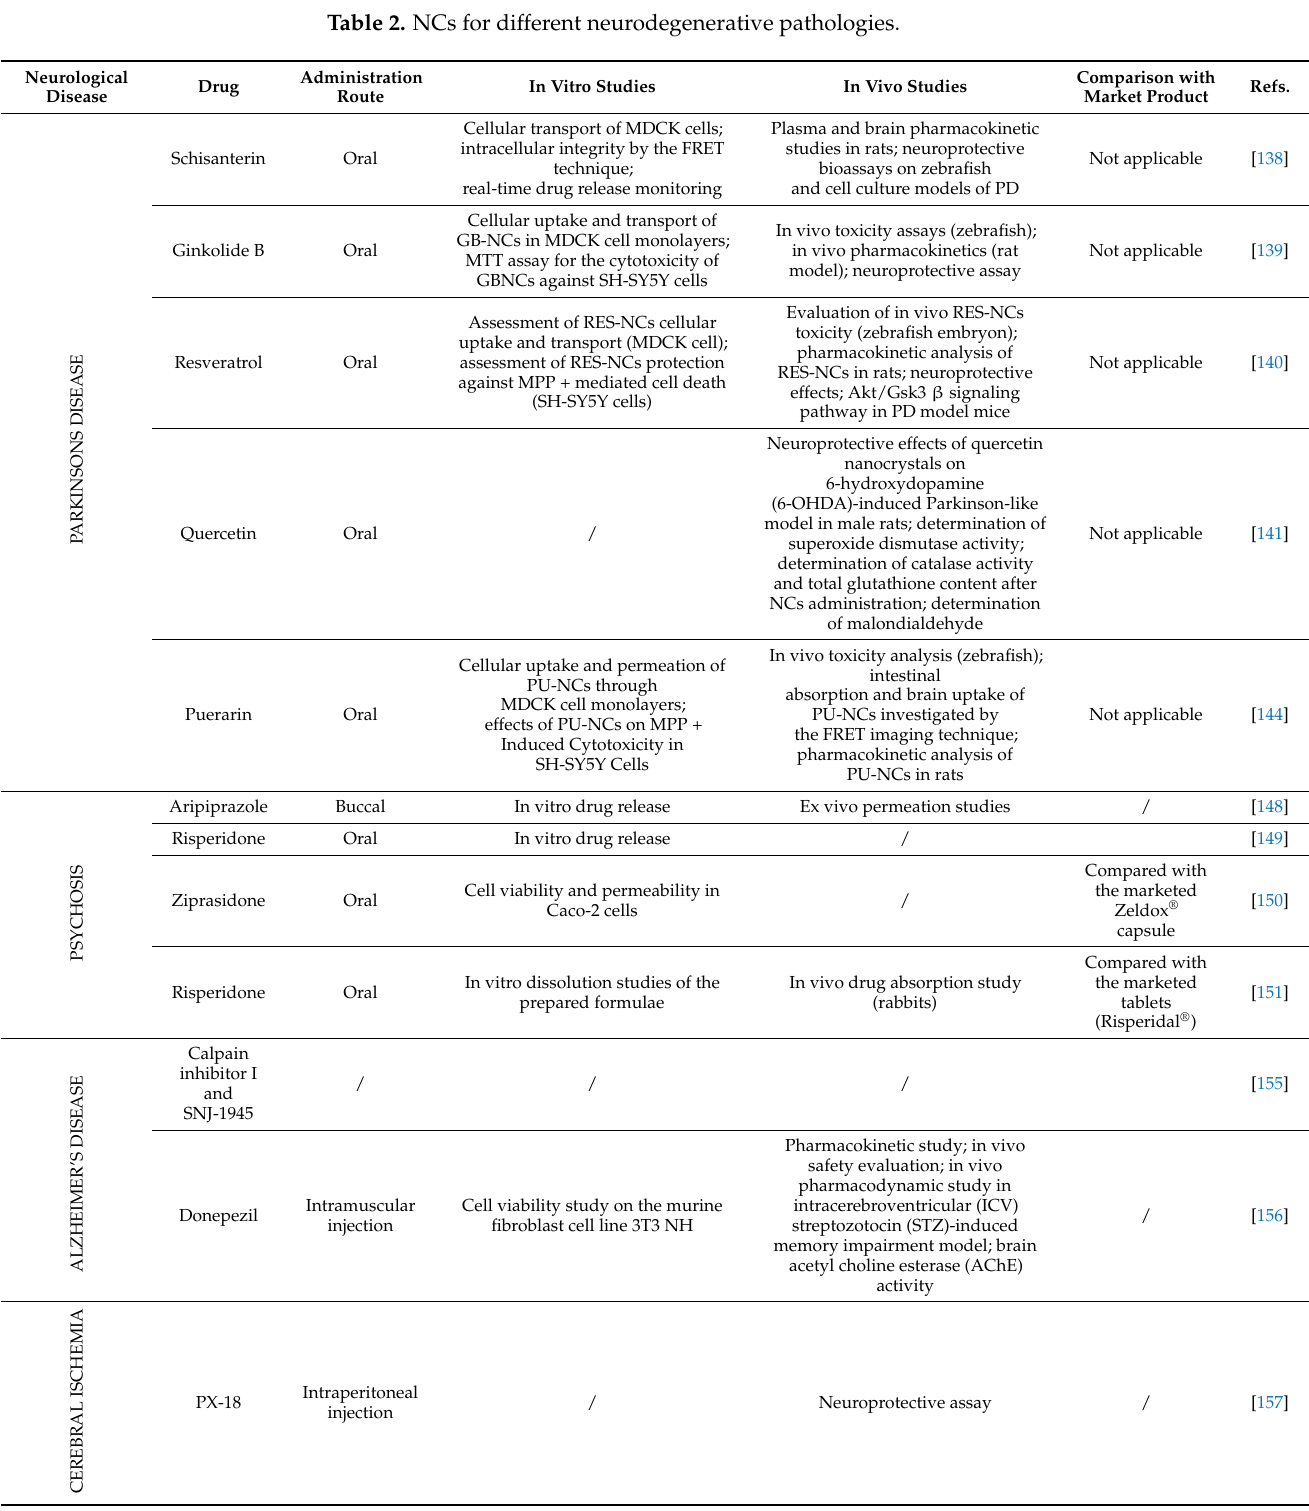
Table 2. NCs for different neurodegenerative